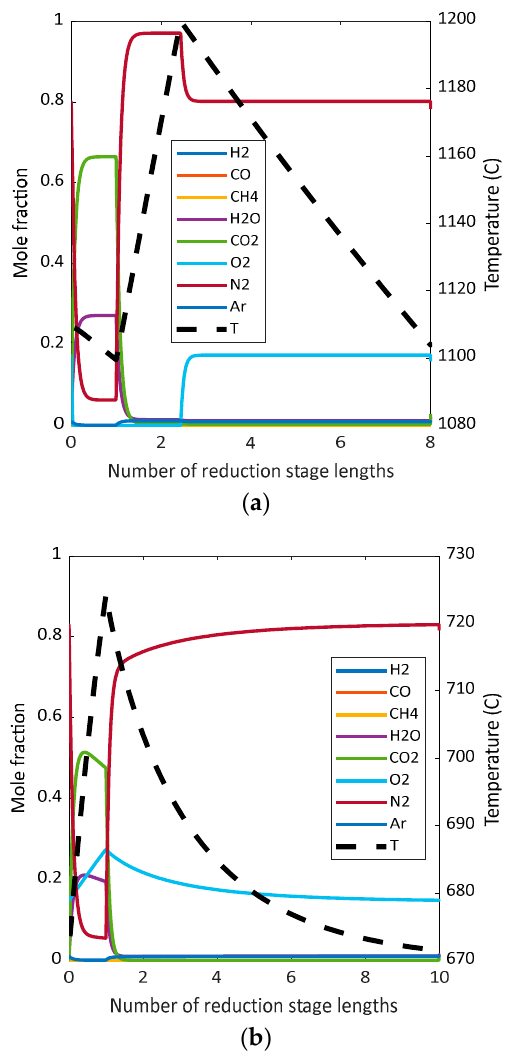
Figure 1. Composition and temperature over a cycle of operation for a ( a ) gas switching combustion (GSC) reactor (reduction stage length = 178.0 s) and ( b ) gas switching oxygen production (GSOP) reactor (reduction stage length = 253.7 s) in the GSOP–GSC integrated gasification combined cycles (IGCC) plant. The x-axes are normalized by the reduction stage length in each case.